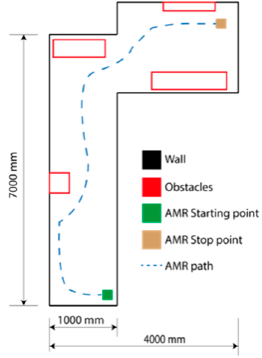
Figure 10. The approximation of the resulting path of the autonomous mobile robot.